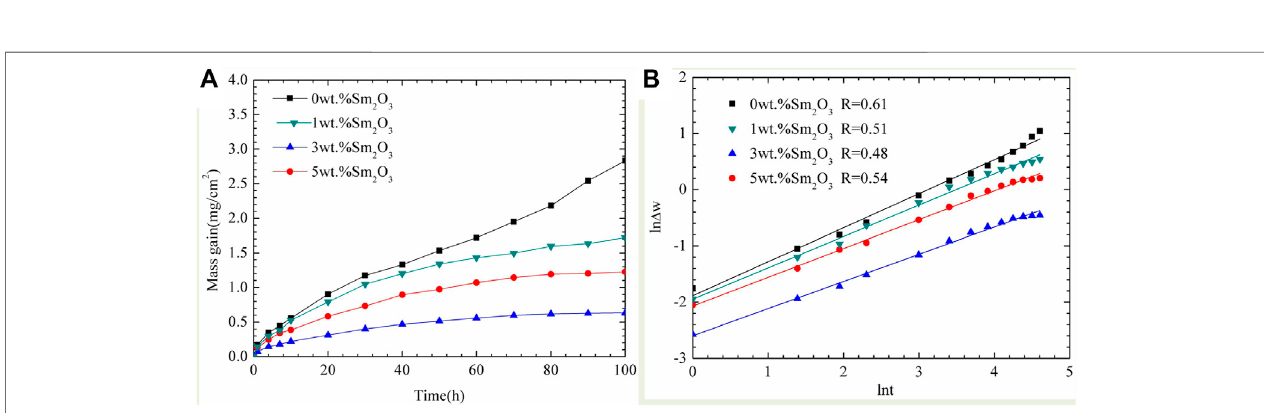
FIGURE 6 | (A) Mass gain vs. time of the NiCoCrAlY- x Sm 2 O 3 coatings; (B) plots of ln Δ w vs. lnt for the oxidation behavior fi tted from the curves in (A) .